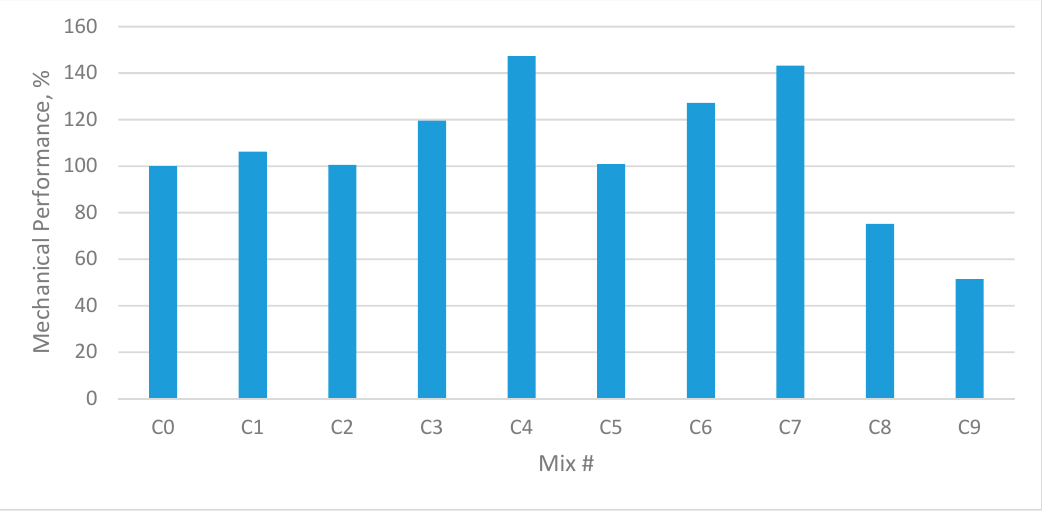
Figure 13. Mechanical performance of each mixture with respect to control mix (C0) with W/B 0.30.